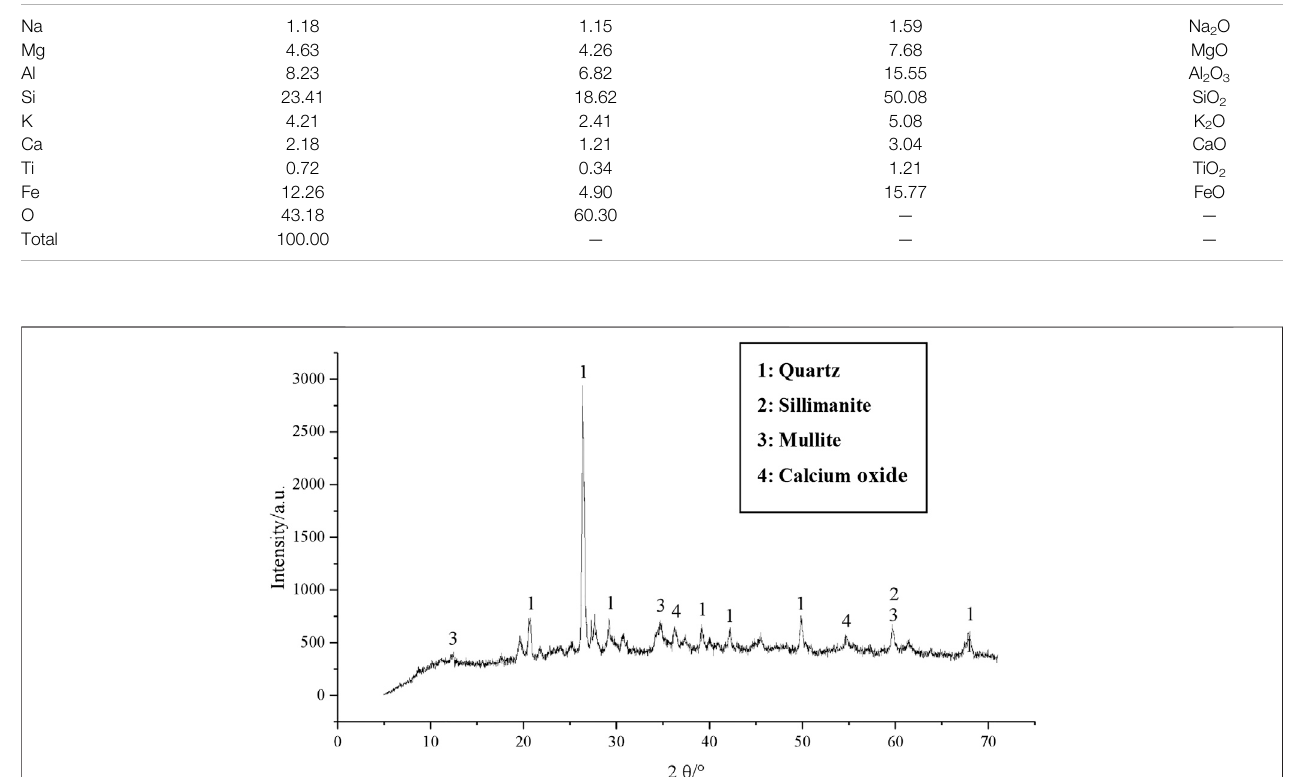
TABLE 7 | Elemental composition for selected areas in the one-part geopolymer-stabilized soil sample with 80% GGBFS and 20% FA at 6.50 mol/L NH solution for FA. Element Weight percentage Atomic percentage Compound percentage Chemical formula